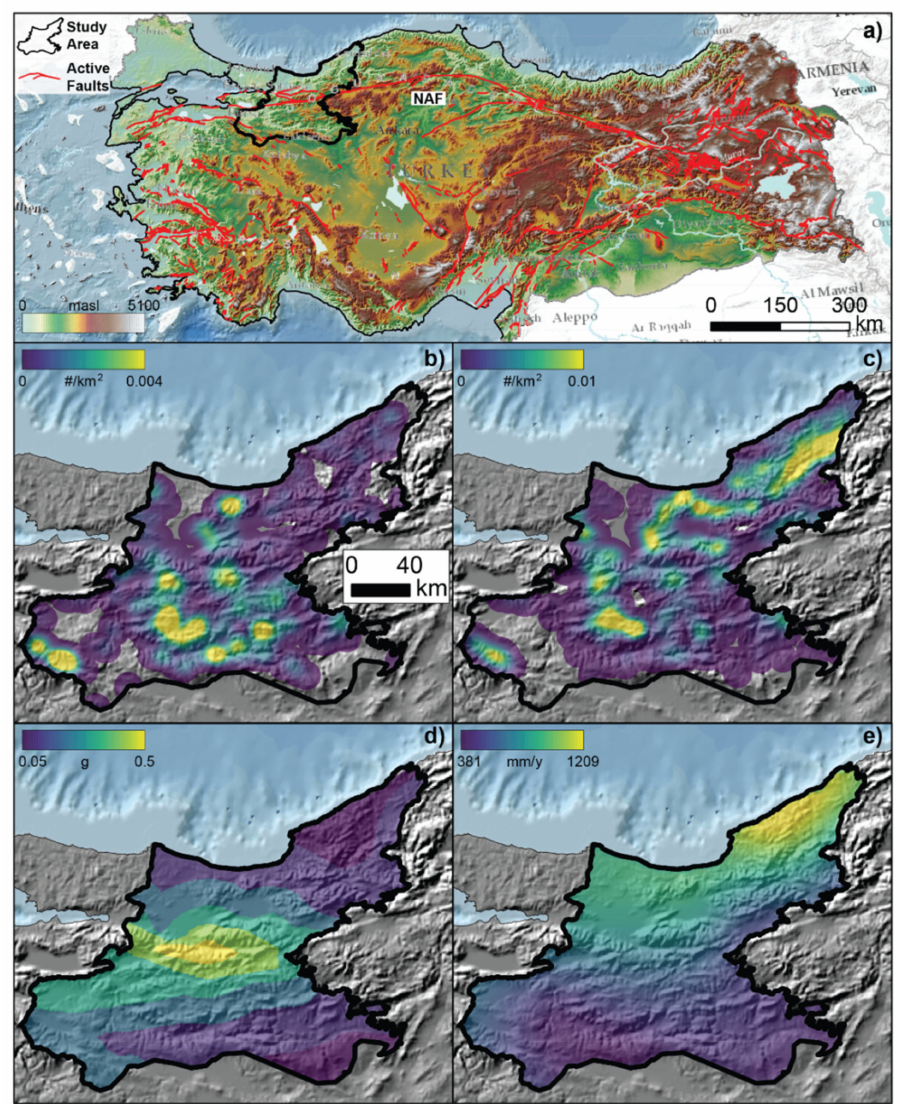
Figure 1. Identification of the study area in Turkey and the North Anatolian Fault ( a ); density maps of inactive ( b ) and active ( c ) landslides (see Section 2.2 for definitions); Peak Ground Acceleration map ( d ) from [40]; mean annual precipitation map ( e ) from